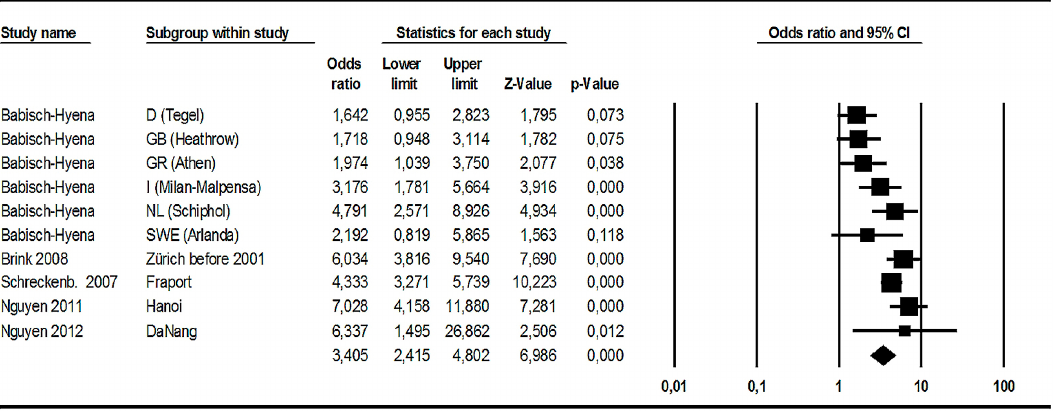
Figure 5. ORs and 95% confidence intervals for the OR referring to a %HA increase by a 10 dB increase (from 50 to 60 dB L den ) aircraft noise. The right part of the graph contains a forest plot of the ORs and their respective 95% confidence intervals. The figures of the last row indicate the summary estimates. Table 2. Air traffic noise—HA rates and the number of respondents in two classes of exposure ( L den ).